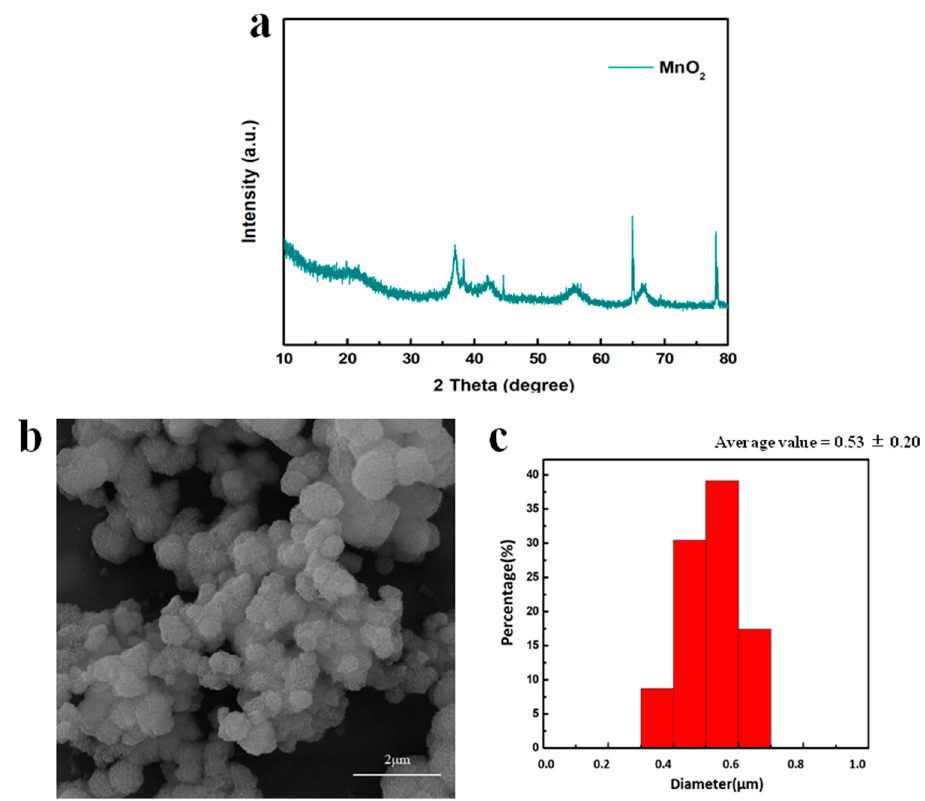
Figure 2. ( a ) XRD pattern of MnO 2 ; ( b ) SEM image and ( c ) size distribution of MnO 2 .